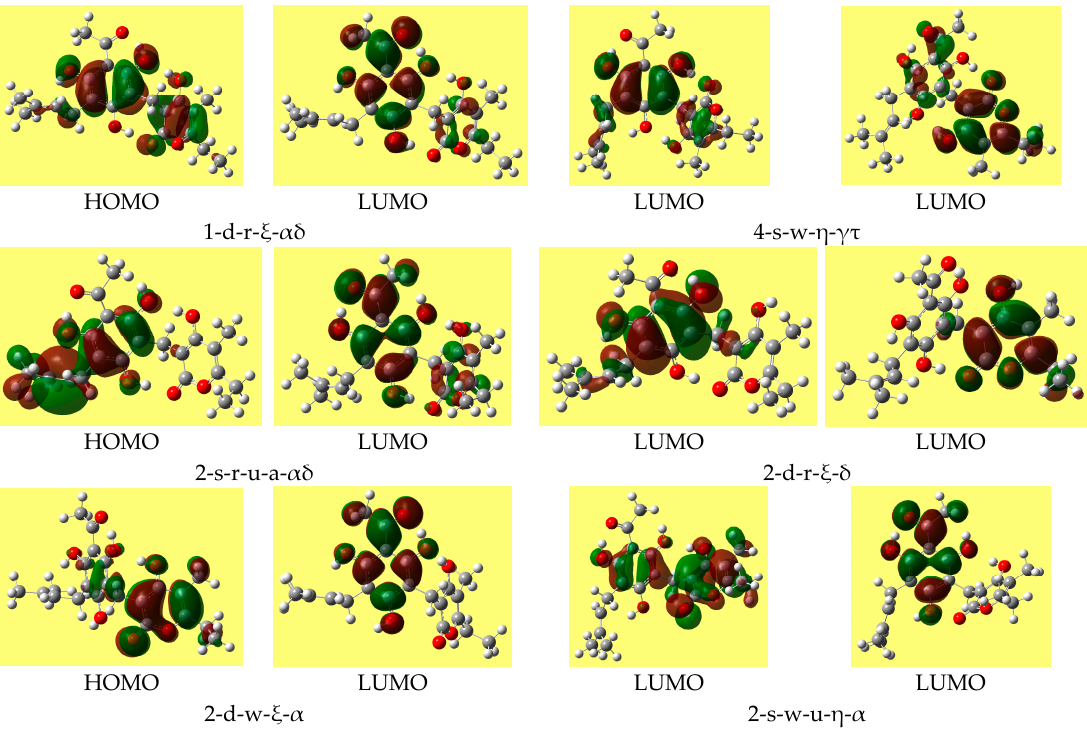
Figure 4. Representative shapes of the frontier molecular orbitals of arzanol, from DFT/B3LYP/6-31+G(d,p) results.